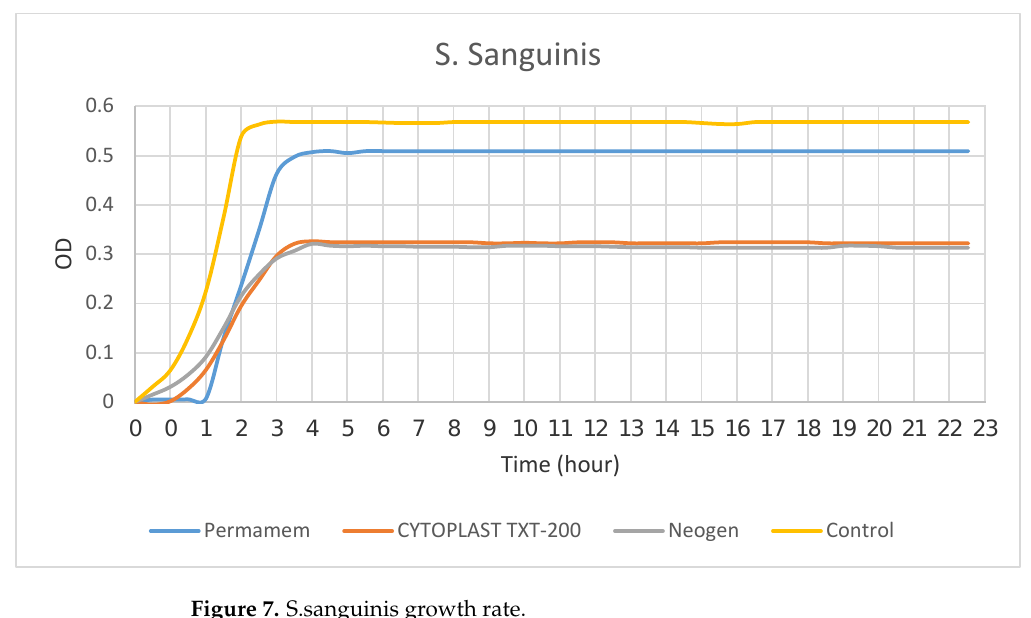
Figure 7. S.sanguinis growth rate.